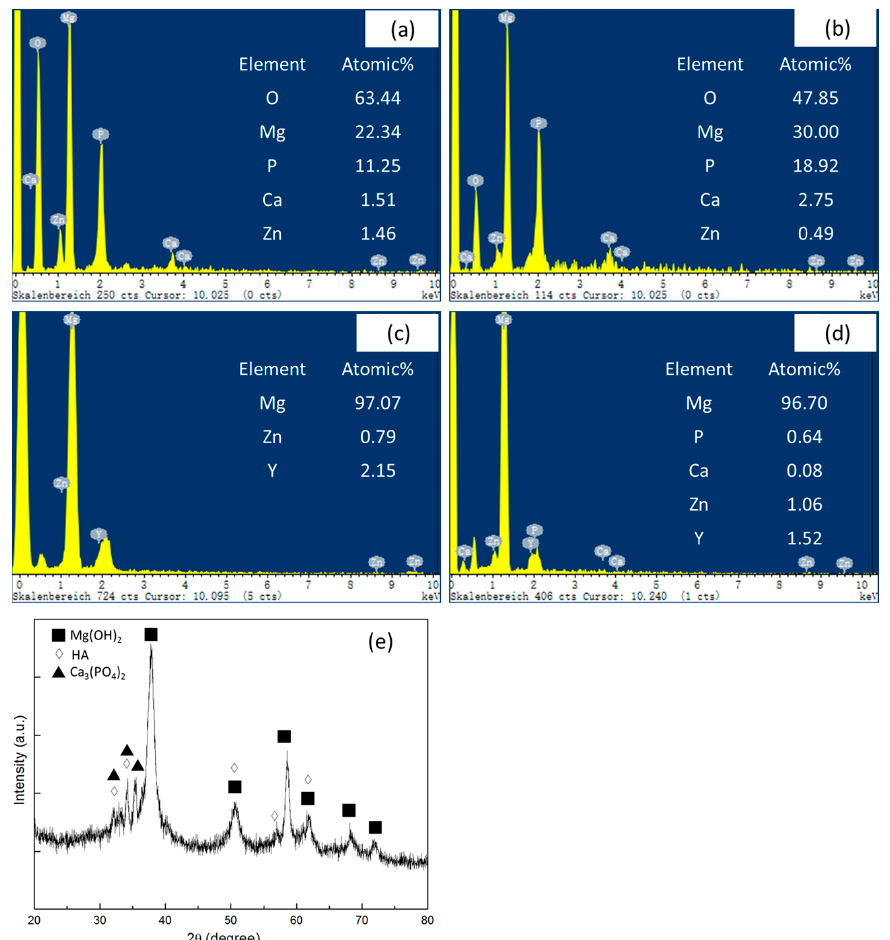
Figure 11. Energy dispersive spectroscopy (EDS) spectrums of surface corrosion layer in ( a ) MgZnY-C alloy and ( b ) HA-C alloys; EDS spectrums of the ( c ) MgZnY-C alloy and ( d ) HA-C alloy before immersion test; ( e ) X-ray diffraction (XRD) pattern of the surface corrosion layer in HA-C alloy.